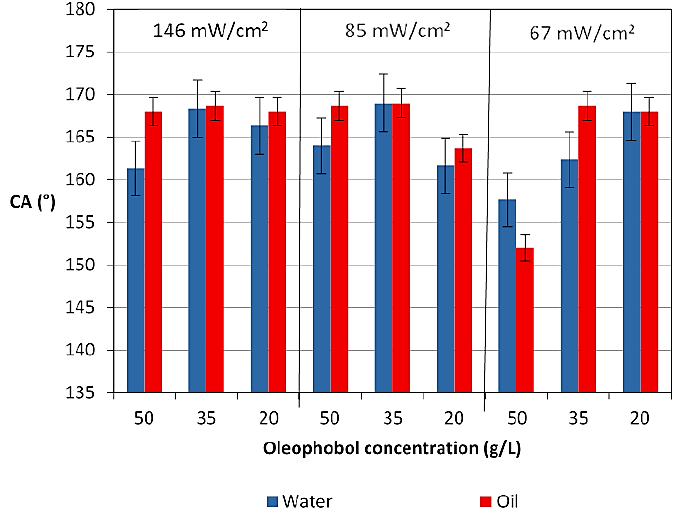
Figure 6. Water and oil CA on PM fabric vs. Oleophobol concentrations for each UV